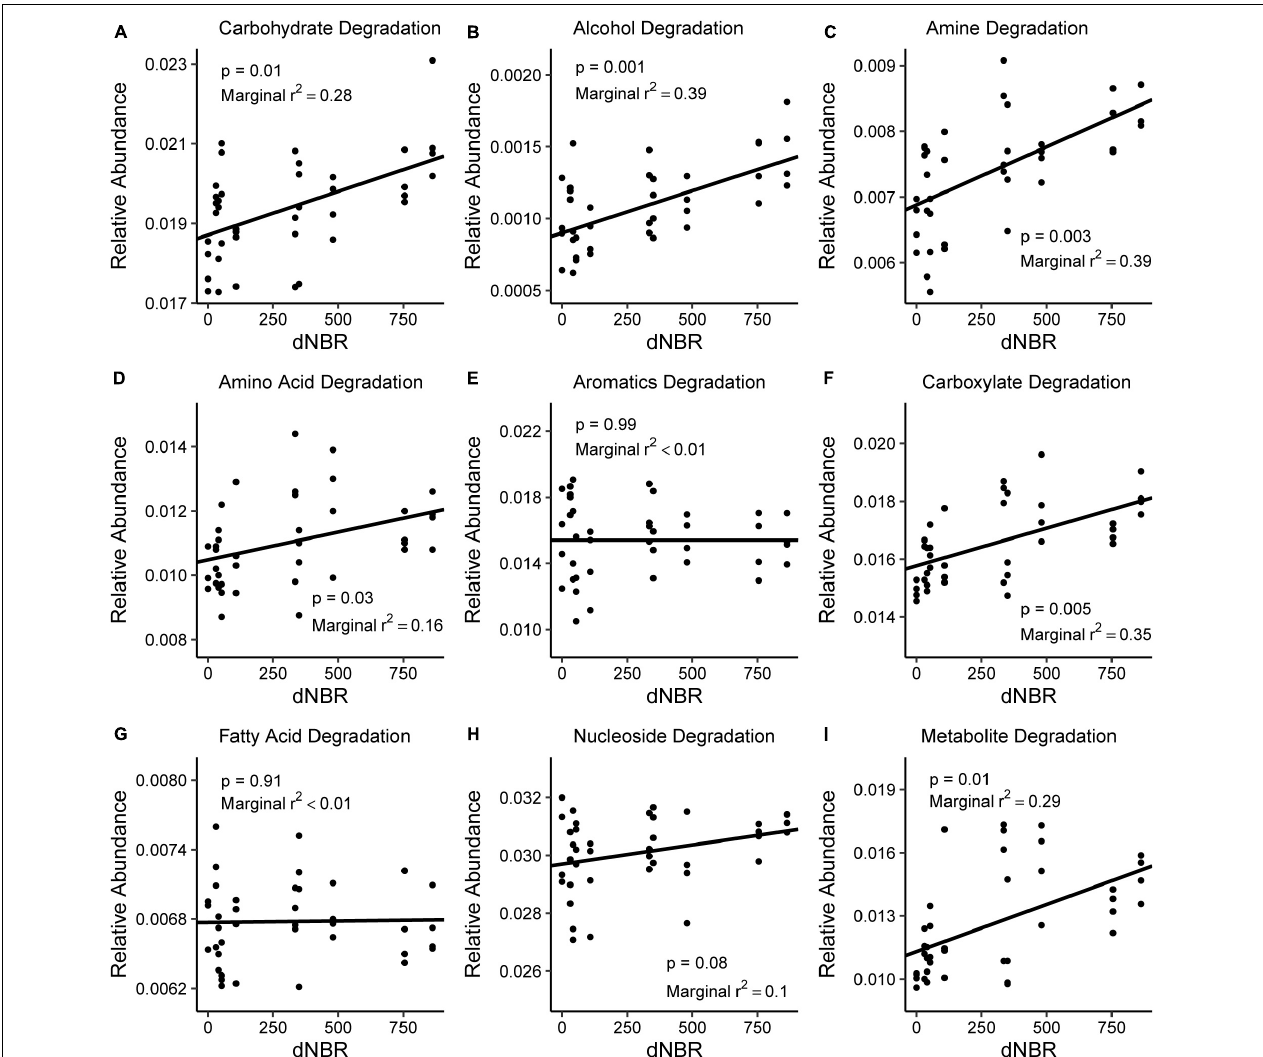
FIGURE 6 | Relationships between burn severity and the relative abundance of imputed C-degradation pathways including (A) carbohydrate, (B) alcohol, (C) amine, (D) amino acid, (E) aromatic compound, (F) carboxylate, (G) fatty acid, (H) nucleoside, and (I) secondary metabolite degradation pathways. The relative abundance of all C-degradation pathways was estimated using